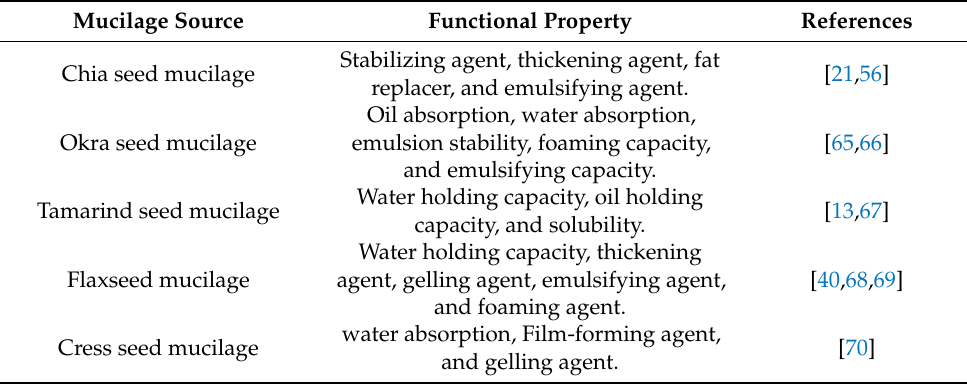
Table 2. Functional properties of various plant-based mucilage. Mucilage